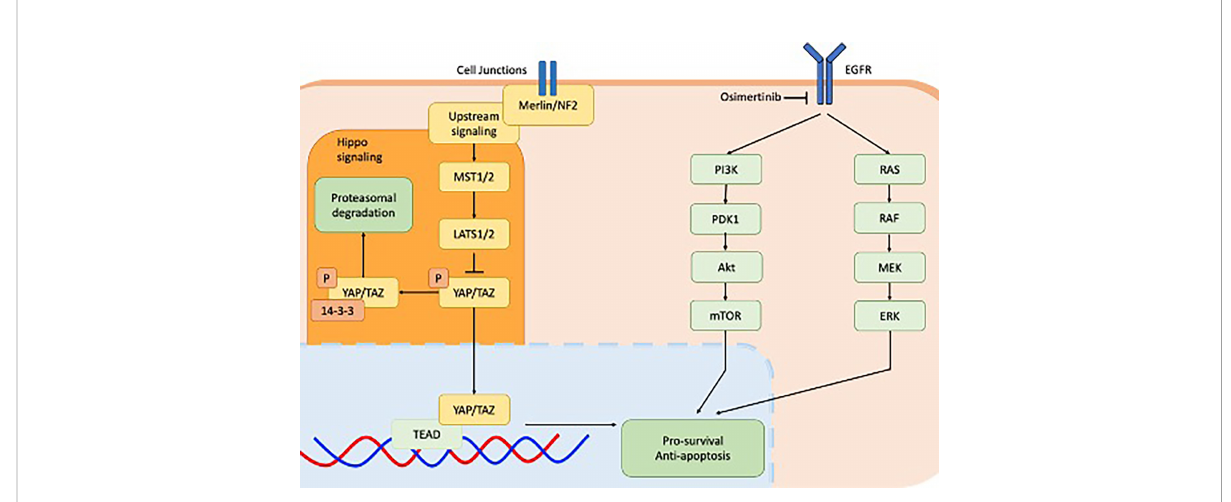
FIGURE 1 Cell signalling pathways implicated in EGFR -mutant non-small-cell lung cancer including downstream signalling of EGFR receptor via the PI3K- AKT pathway (green) and MAPK pathway (green) and the YAP/TEAD hippo signalling pathway downstream of Merlin/NF2. Both pathways converge on the apoptosis